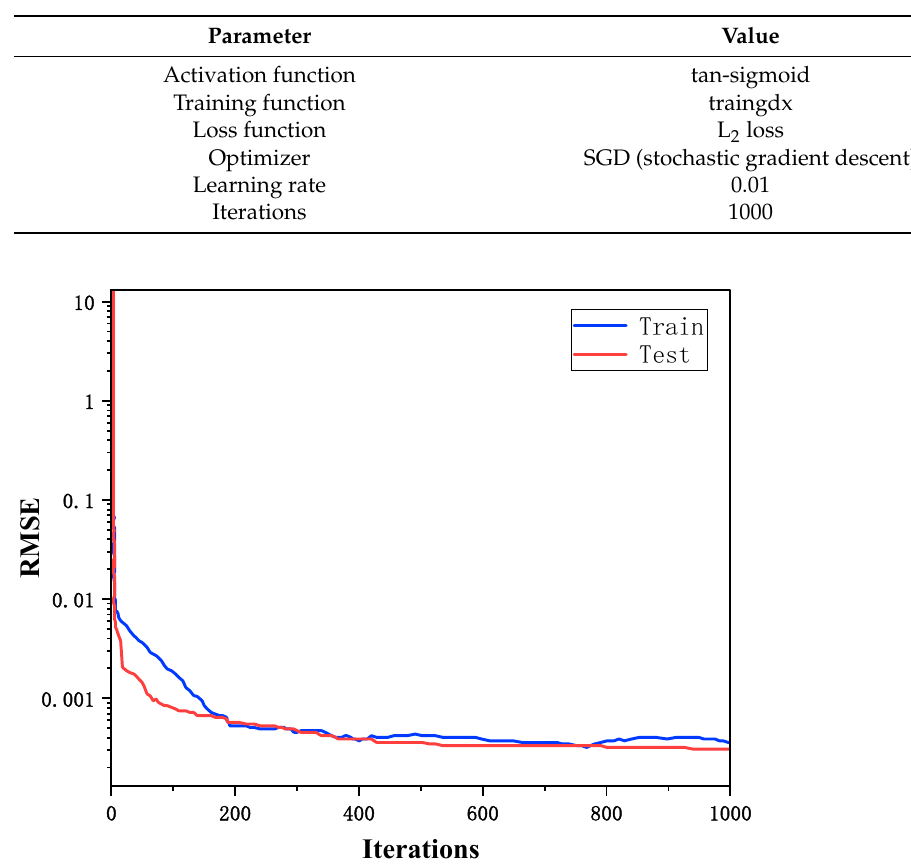
Figure 12. Prediction accuracy of the model with the number of iterations.